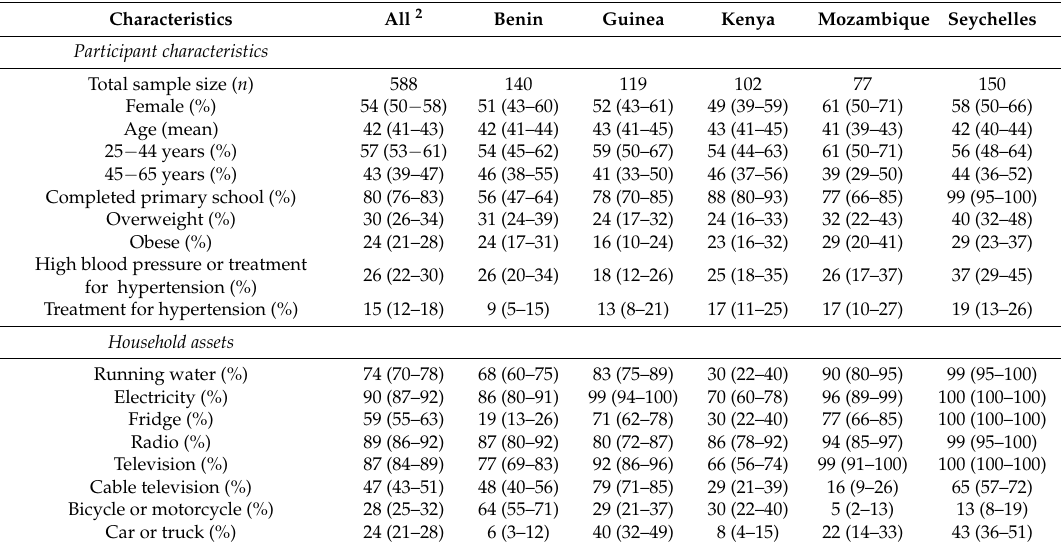
Table 1. Socio-demographic characteristics of the participants 1